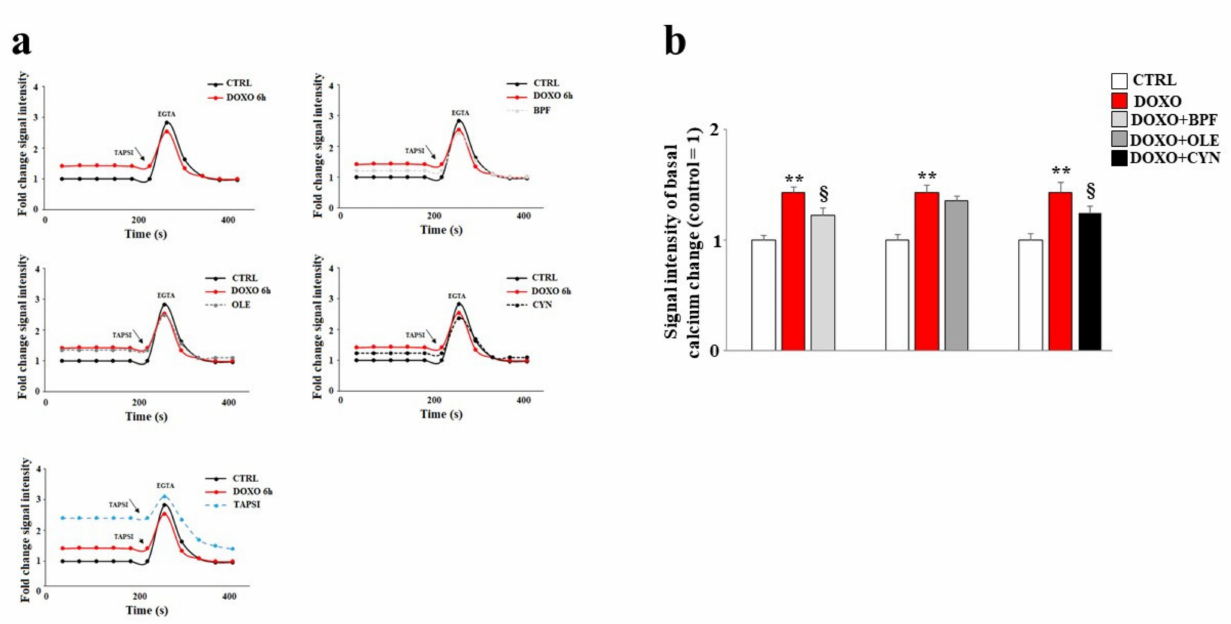
Figure 5. Measurement of basal calcium ion levels. Modulation of the basal concentration of calcium ions released from the endoplasmic reticulum after treatment with 1 µ M of DOXO alone or after co-treatment with DOXO and BPF (5 µ g/mL), OLE (1 µ M), or CYN (1 µ M) was measured (panel a ). Treatment with TAPSI was used as a positive control. Relative quantification of the signal intensity of the basal calcium change was conducted (panel b ). Representative graphs of three independent experiments are shown. ** denotes p < 0.01 vs. control; § denotes p < 0.05 vs. DOXO. The Analysis of Variance (ANOVA) was followed by the Tukey–Kramer comparison